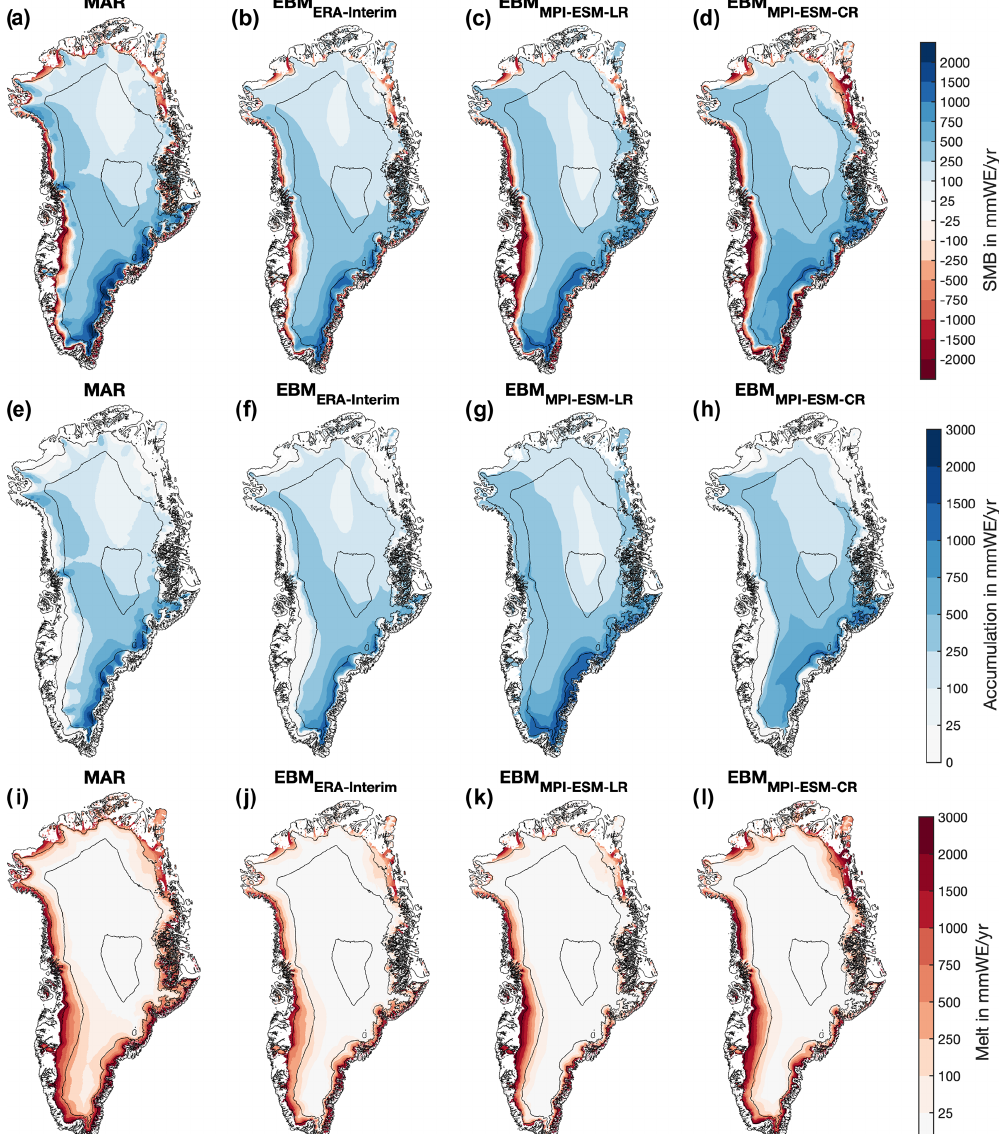
Figure 1. (a–d) SMB, (e–h) accumulation, and (i–l) melt from (a, e, i) MAR and EBM simulations forced with (b, f, j) ERA-Interim, (c, g, k) MPI-ESM-LR, and (d, h, l) MPI-ESM-CR for historical climate conditions. The values are averaged over 1980–2010. All variables are interpolated on the ISMIP6 topography and shown only for glaciated points. Note that accumulation is obtained as the residual of SMB minus melt as MAR does not provide accumulation as a direct output variable. Black contours mark surface elevations of 0, 1000, 2000, and